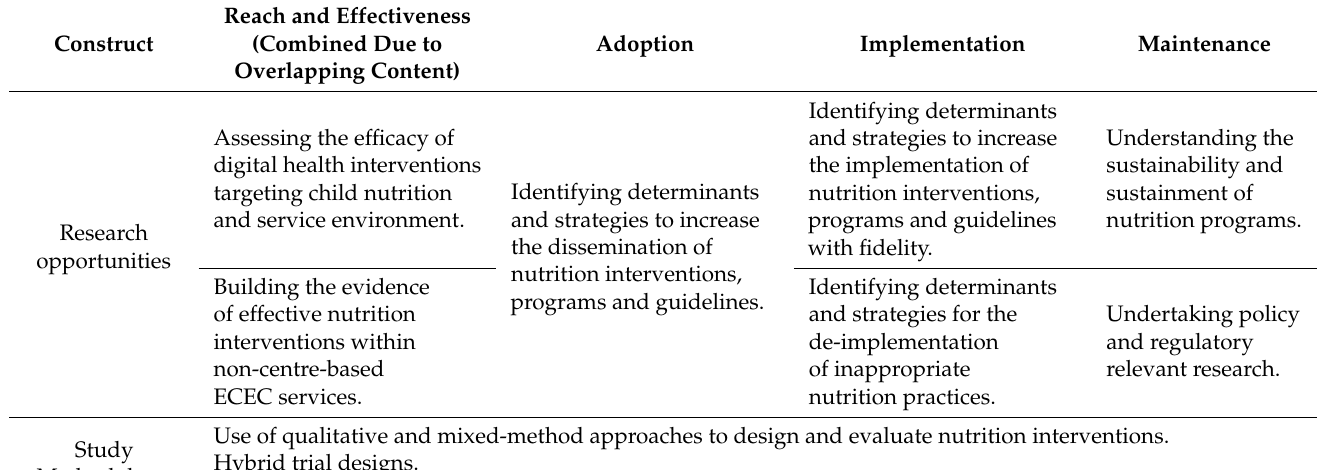
Table 1. Opportunities to advance nutrition intervention research in early childhood and education care (ECEC) settings according to the reach, effectiveness, adoption, implementation, maintenance (RE-AIM)